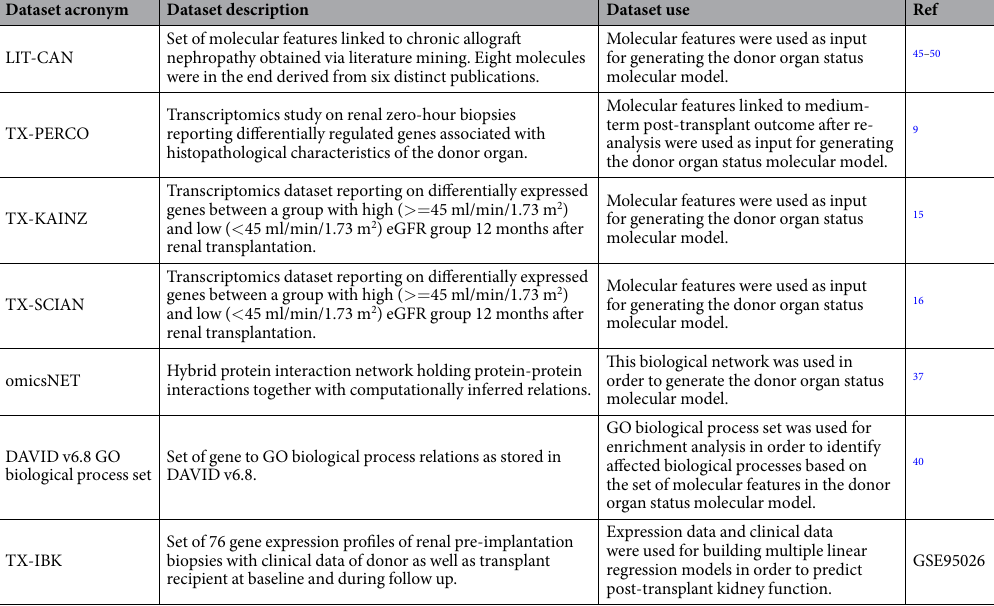
Table 1. Listing of datasets used. Overview and brief description of used datasets within the present study. The specific use of the dataset is given along with the links to original